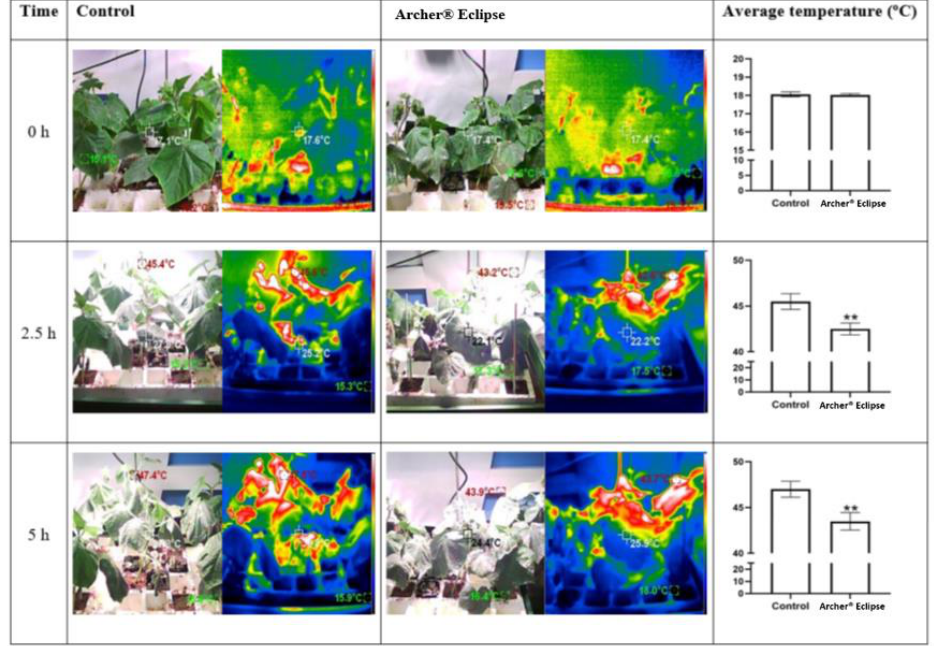
Figure 3. Thermographic images and average temperature at 0 h, 2.5 h, and 5 h from the beginning of the application of sunburn conditions. Values are means ± standard error (n = 15). Differences between means were compared with Fisher’s least significant difference test (LSD; p = 0.05). The levels of significance were represented by p < 0.01 (**).